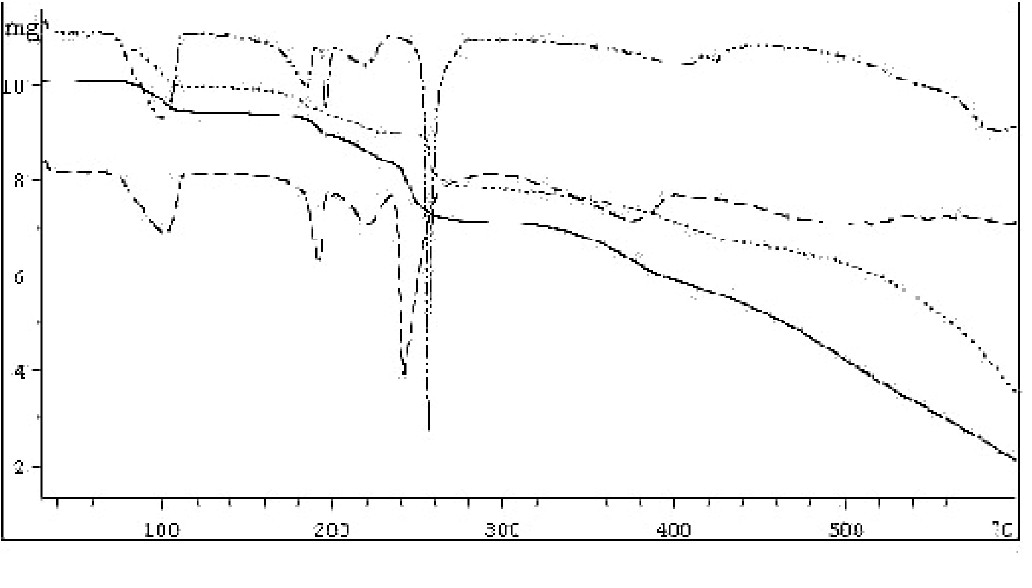
Fig. 1 The TG and DTGcurves : ||, |{ (HBz) 2 Cu 2 Cl 6 ; ° ° ° ° ° ° ° , { °° { °° {, 1:1 mixture of (HBz) 2 Cu 2 Cl 6 and CuCl 2 ¢ 2H 2